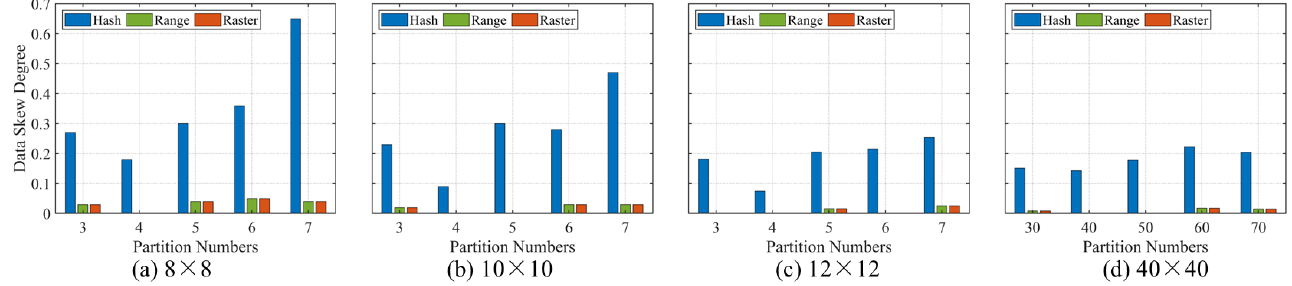
Figure 6. The data skew for various image layouts.